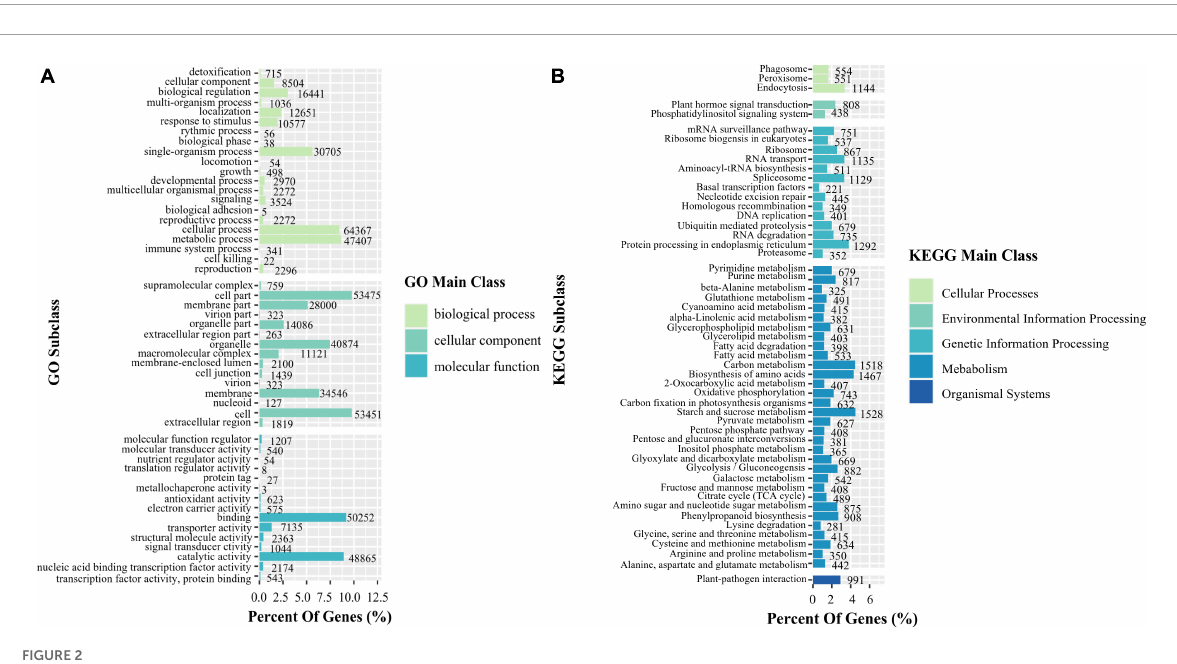
FIGURE2 Functional classification of transcripts based on the GO (A) and KEGG (B) in K. melanthera